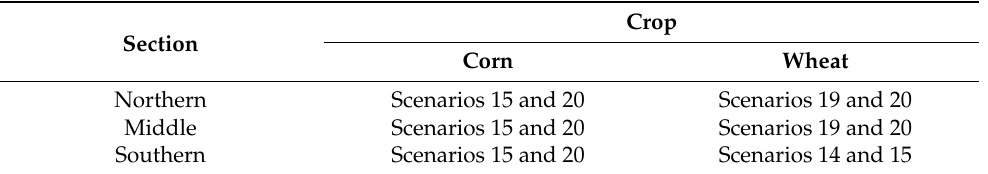
Table 6. Suitable scenarios based on a low waterlogging frequency and ACDWI at representative fields with observation wells near and far from the